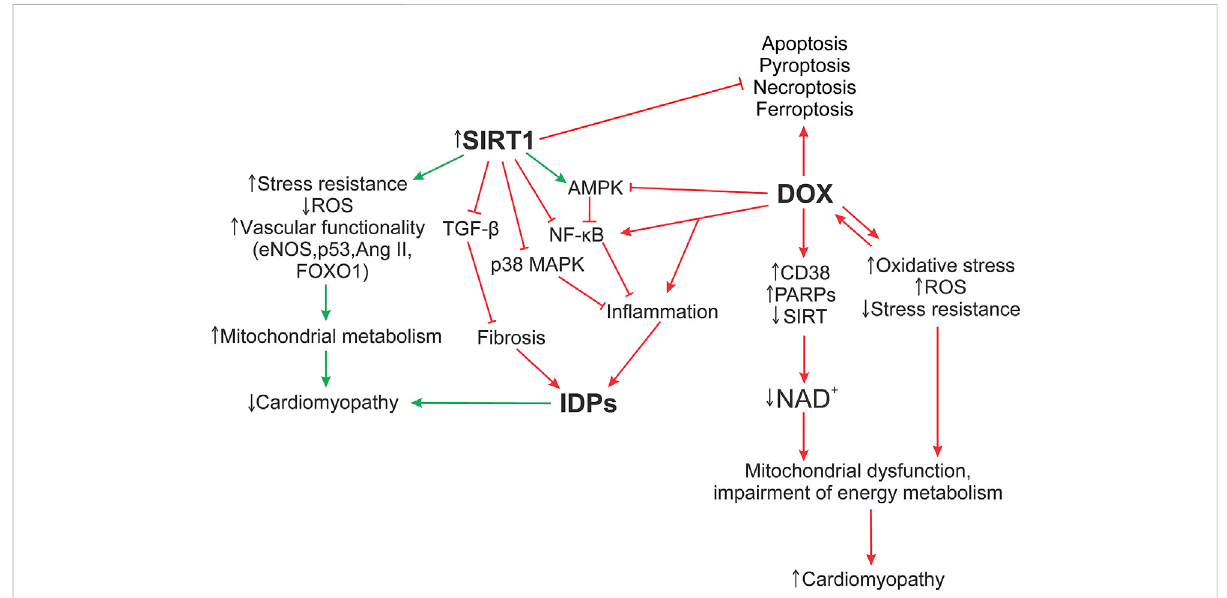
FIGURE 5 Hypothesis of the SIRT1 protective effect on myocardial ID proteins in DOX-induced cardiotoxicity. The formation of DOX-induced cardiotoxicity occurs due to the triggering of oxidative stress, in fl ammatory processes via the activation of TLR4/MAPKs/NF- κ B pathways, and doxorubicin also inhibits the work of topoisomerase 2 β . As a result, DNA damage increases, the work of cell compartments (mitochondria, sacroplasmicreticulum)isdisrupted,andthestructureofthemyocardialIDisdestroyed.Additionally,activationofDNArepairenzymes,PARPs, CD38, leads to a decrease in the functional activity of sirtuins, disruption of the work of Electron transport chain Complex I, which uses NADH as an electrondonor.DamageofComplex1andATPproductionleadstotheaccumulationofROS,whichincreasethelevelofoxidativestress.In fl uencing SIRT1initiatessystemsthatreduceDOX-inducedcardiotoxicity,suchasantioxidantdefensesystemsthatrestoremitochondrialbiogenesisdamaged by oxidative stress; autophagy activation systems that are disrupted by DOX, leading to accumulation of non-degradable autolysosomes; activates SIRT1/AMPK and inhibits SIRT1 p38 MAPK/NF- κ B/TGF- β signaling pathways that contribute to the normalization of the regulation of in fl ammatory responses, improve the functioning of ID structures, modulate apoptotic processes, and exert anti fi brotic regulation. It is interesting to note the possible role of SIRT1 in the regulation of switching between the processes of necroptosis, pyroptosis, and apoptosis. However, these mechanisms are not considered in this study. AMPK, 5 ′ AMP-activated protein kinase; Ang II, angiotensin II; CD38, cADP-ribosesynthases; DOX, doxorubicin; eNOS, EndothelialNOS;ForkheadboxproteinO1;IDPs,intercalateddiscproteins;NF- κ